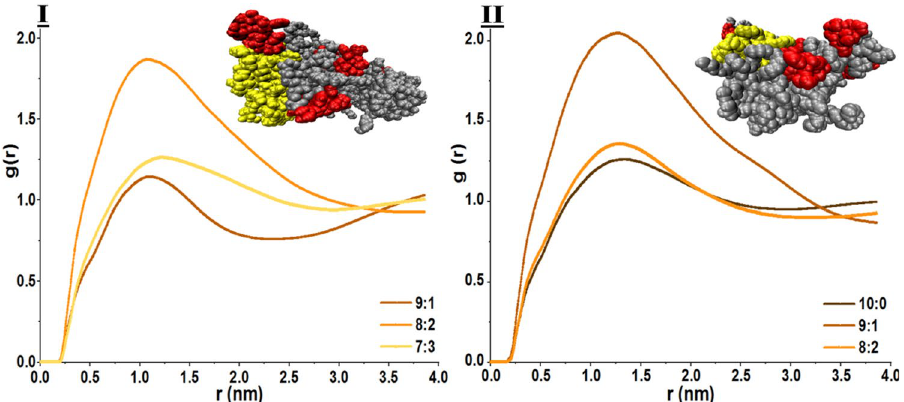
Figure 5. Morphology of stable NPs. Radial distribution function (RDF) of NP around the drugs. ( I ) Radial distribution function (RDF) of NP around the drugs for PLGA 3kDa -PEG 2kDa at the 8:2 ratio together with a snapshot of the final particle verify the highest drug loading and encapsulation. with 5 antitumor molecules in the mass and 3 on the surface. ( II ) RDF plot for the NPs based on PLGA 4.5 kDa -PEG 2kDa declares the highest polymer distribution around the DTX molecules at PP:PPR 9:1. A snapshot of the polymeric nanocarrier also verifies the results. Notably, all RF-targeted polymer chains are located at the surface.